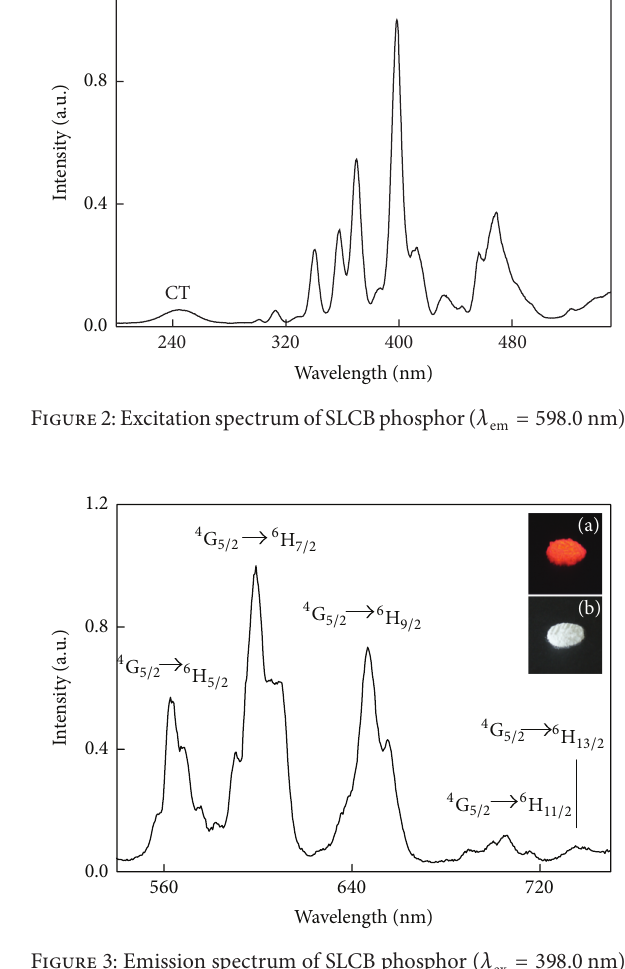
Figure 3: Emission spectrum of SLCB phosphor ( 𝜆 Inset of (a): fluorescence from SLCB phosphor under 365.0 nm radiation. Inset of (b): SLCB phosphor under natural light.